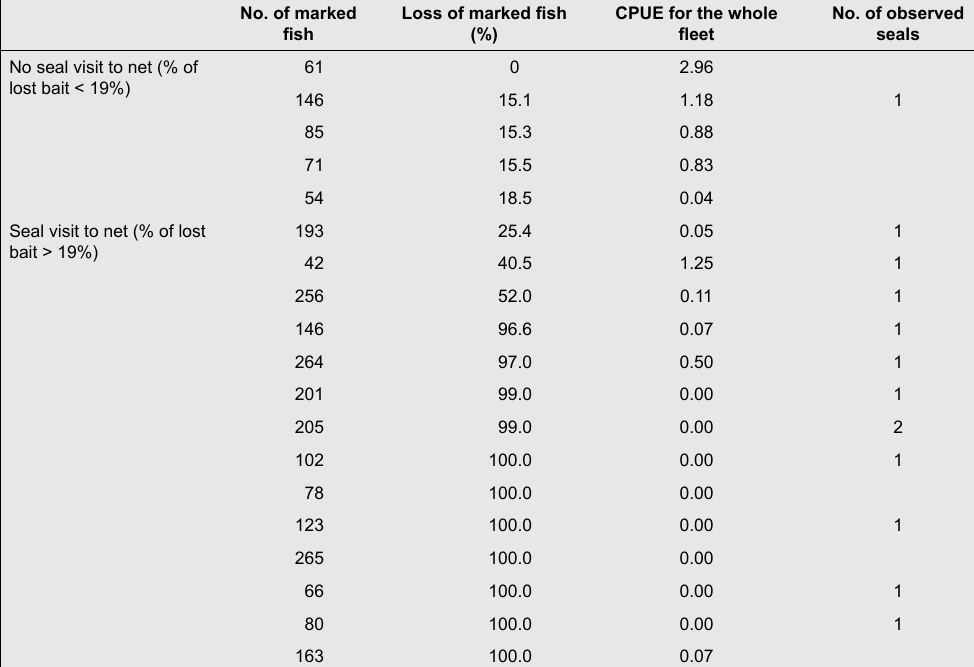
Table 3. Marked and lost fish in 19 experimental net deployments, including CPUE (kg herring m net -1 day -1 ) in the adjoining nets, and the number of observed seals.